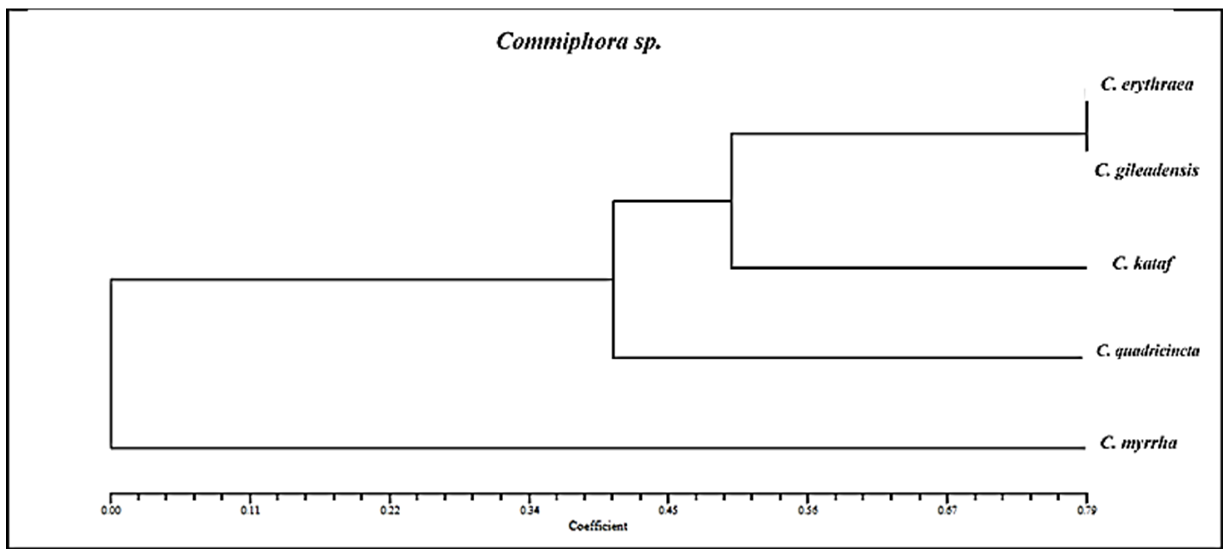
8 Figure 6. Commiphora kataf ; ( A ): whole plant in leafy stage; ( B ): whole plant in naked stage; ( C ): A